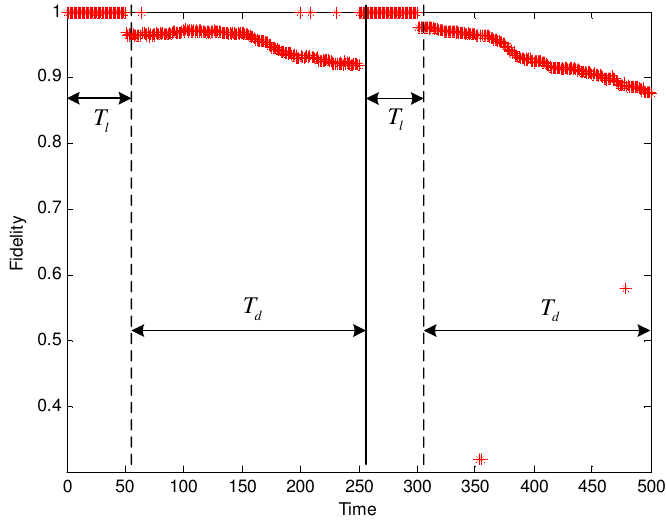
Figure 7. The changing fidelity during the data